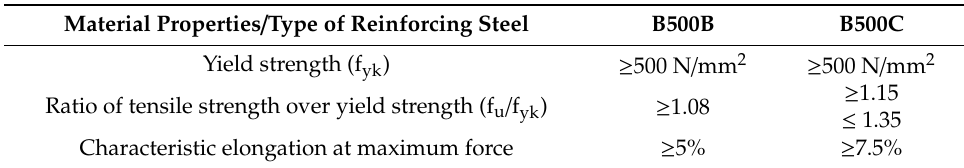
Table 1. Specification for the cast-in anchor bolts